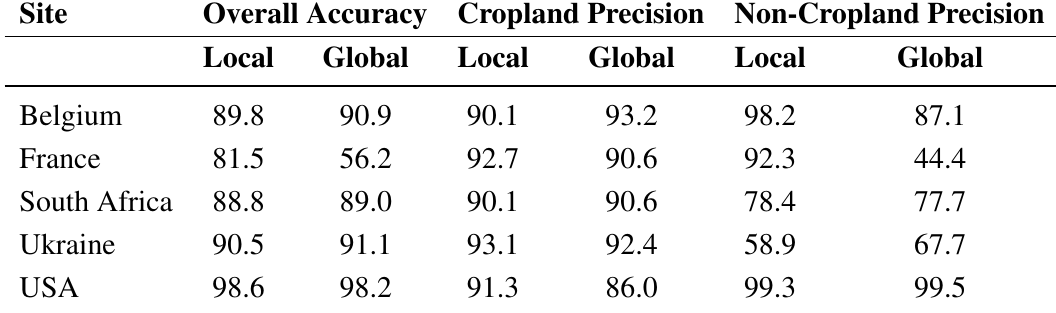
Table 6. Impact of baseline resolution on accuracy. The“local” land cover information refers to locally available high resolution maps, while “global” refers to the 300-m CCI Land Cover